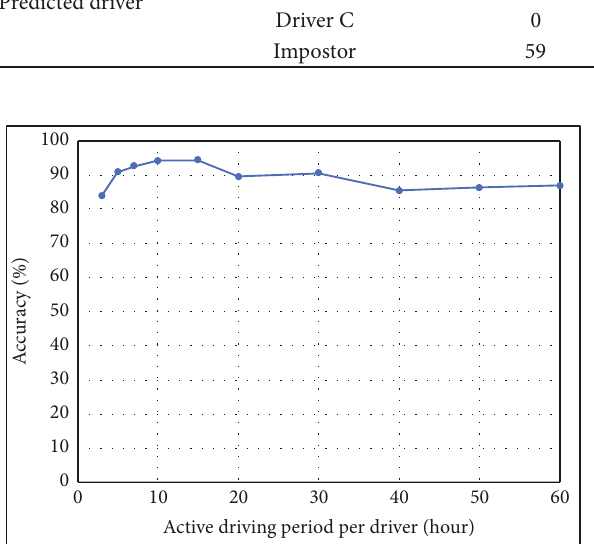
Figure 16: Plot of the accuracy across active driving period per driver.